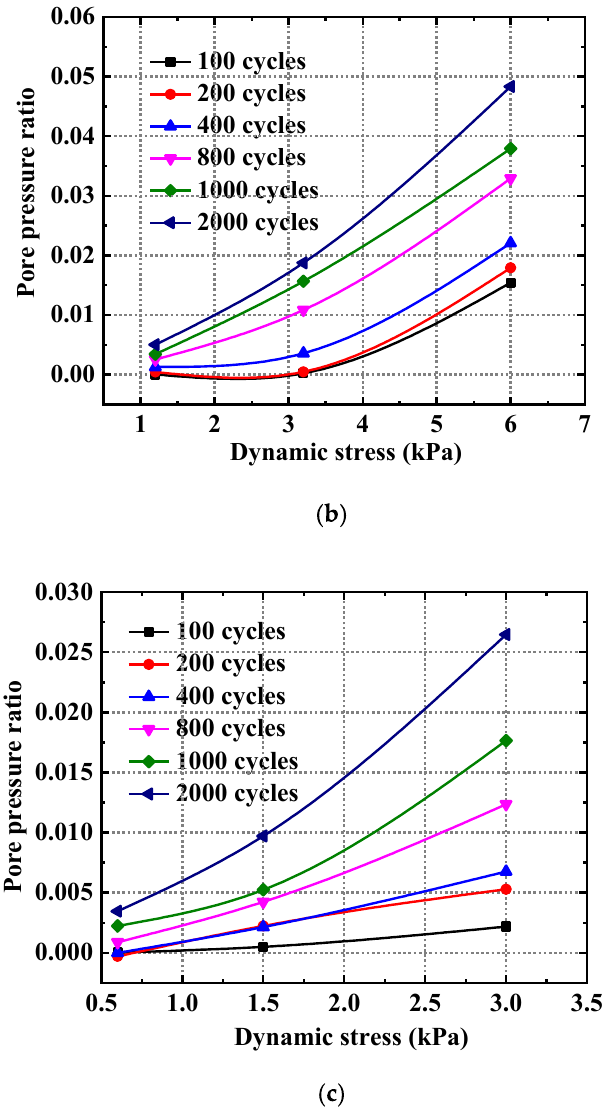
Figure 16. Pore-pressure-ratio variation under different depths. ( a ) Depth = 0.5 m; ( b ) Depth = 1.5 m; ( c ) Depth = 2.5